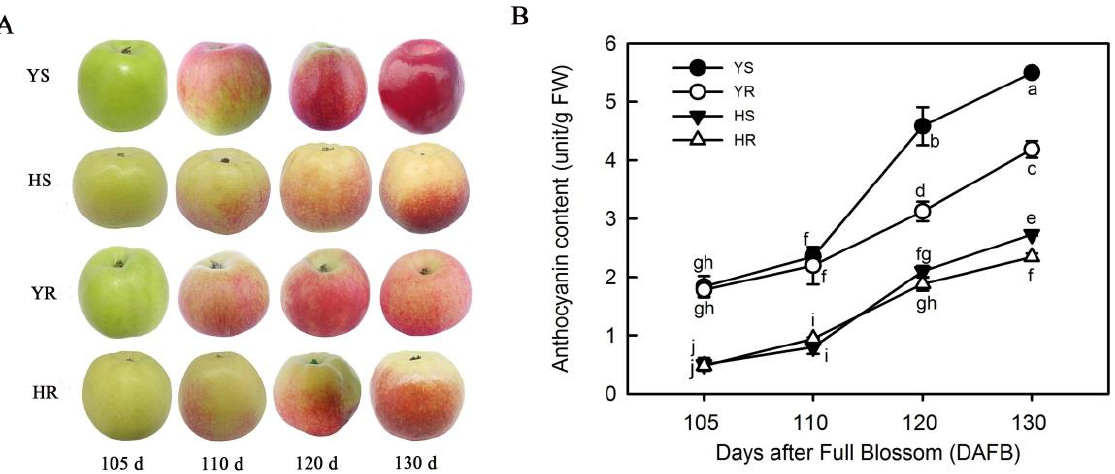
Figure 1. Apple appearance and anthocyanin content. ( A ) Apple phenotypes. ( B ) Total anthocyanin content. YS and YR represent Huashuo and Huarui apples in the high-altitude orchard, respectively; HS and HR represent Huashuo and Huarui apples in the low-altitude orchard, respectively. Lowercase letters indicate significant differences at p < 0.05.